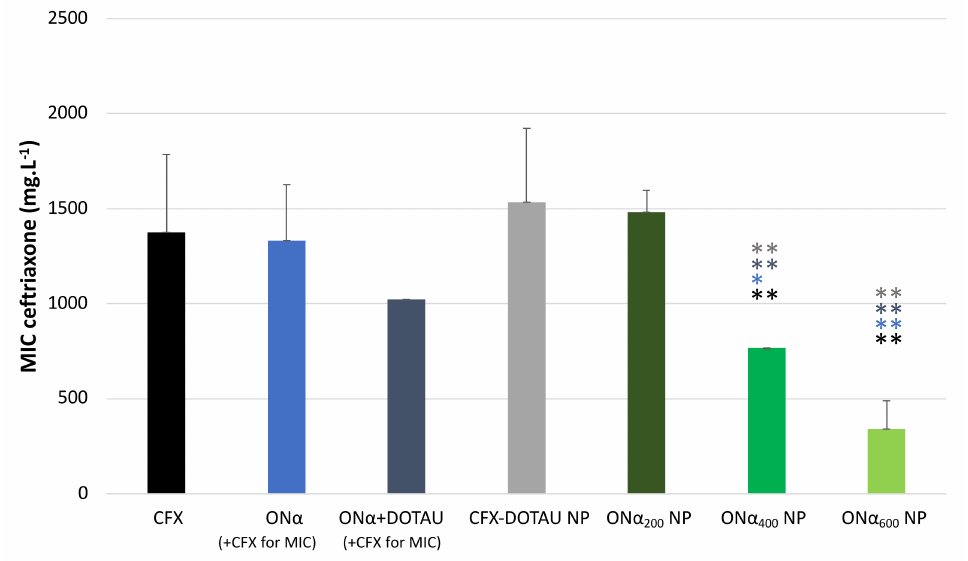
Figure 8. CFX MIC of ON α NP on ESBL-producing E. coli compared to CFX–DOTAU NP and control conditions (* p < 0.05 and ** p < 0.01 Student t-test; NB: the concentration cited in brackets is the ON α incubation concentration during NP